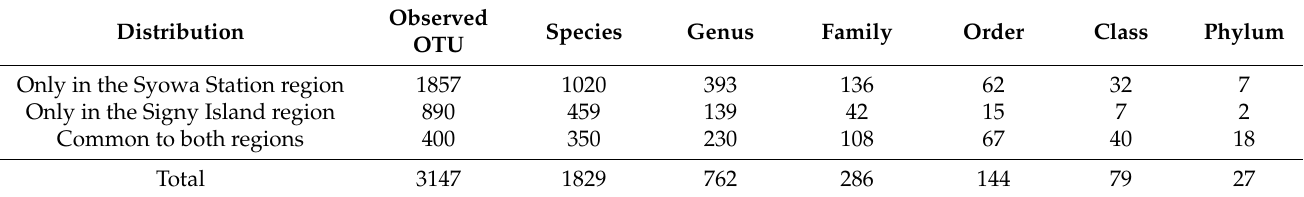
Table 4. Numbers of assigned OTUs and OTU-derived species, genera, families, orders, classes and phyla that were detected only from the Syowa Station region, only from Signy Island and from both regions. The total numbers are equal to those in Table 3.